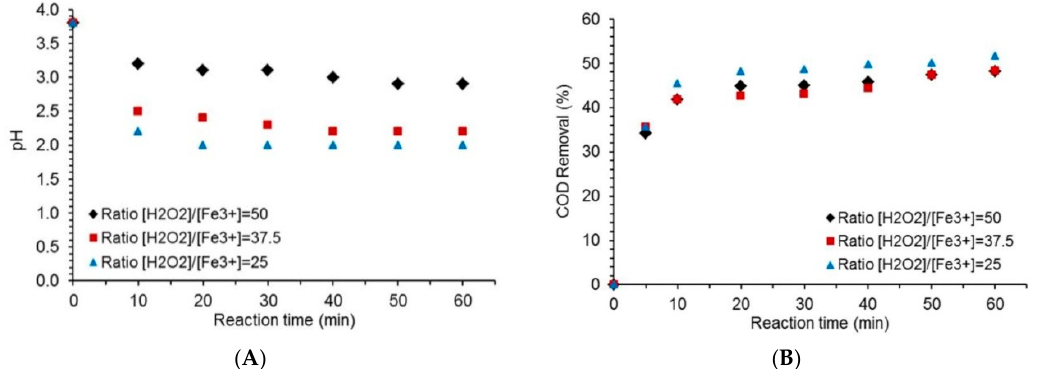
Figure 3. The pH profile ( A ) and removal of COD ( B ) by the Fenton reaction at different [H 2 O 2 ] to [Fe 3+ ] ratios for pH = 3.8 (without adjustment) and the ratio of [H 2 O 2 ] to [COD] = 0.62 (g/g).